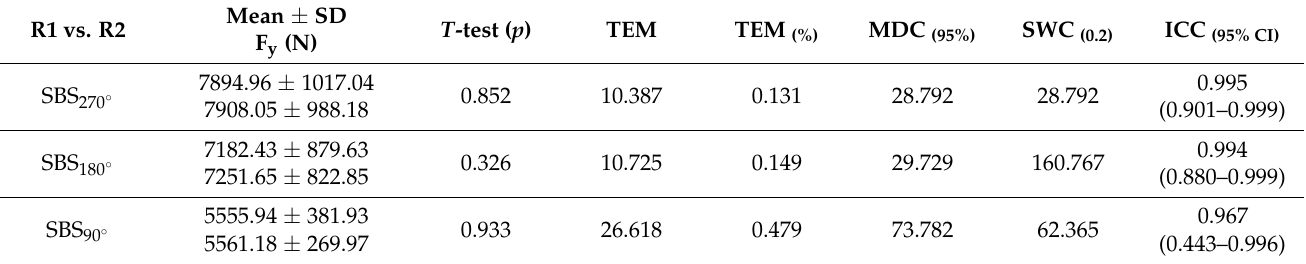
Table 1. Statistical analysis of the absolute and relative reliability of vertical ground reaction force measured during landing in standing back